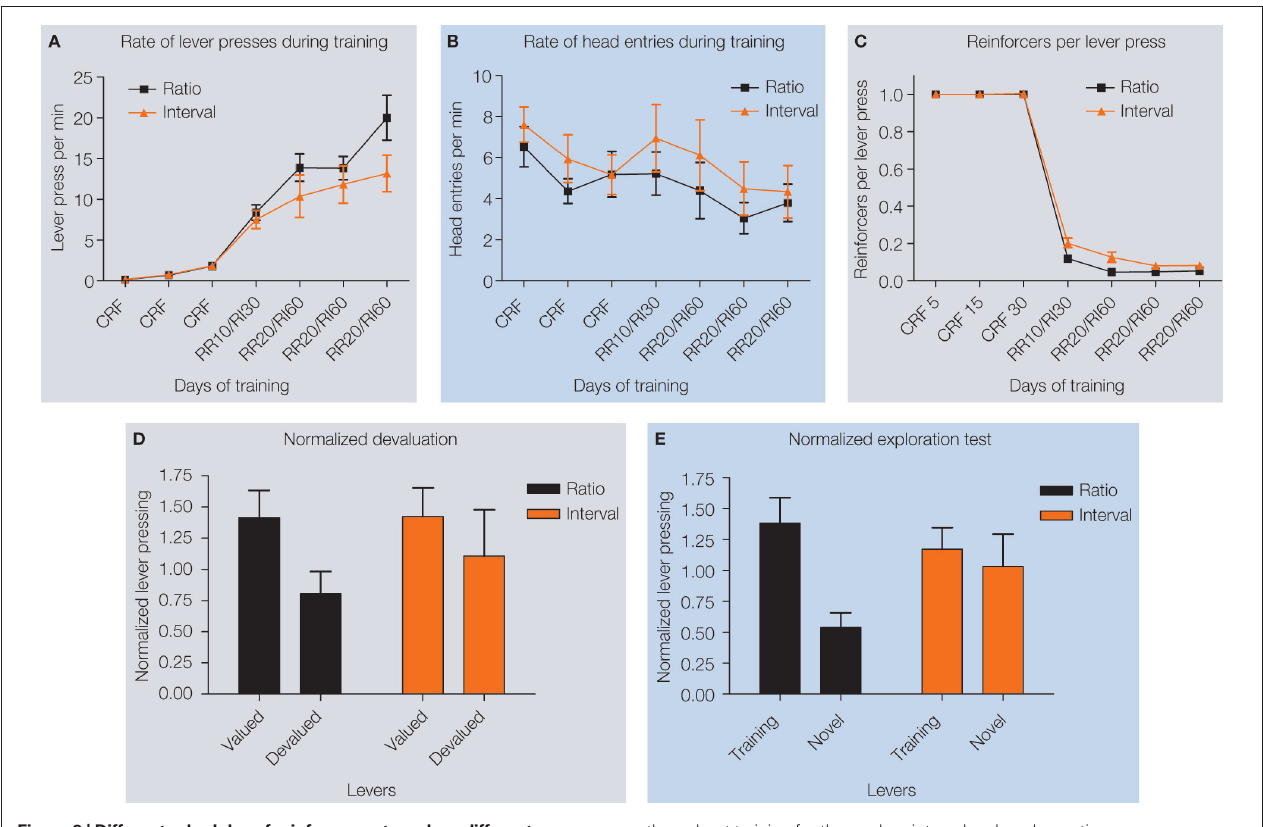
Figure 2 | Different schedules of reinforcement produce different predisposition to habit formation in C57Bl6/J mice. (A) Acquisition of the lever pressing task in animals trained on random ratio and random interval schedules. The rate of lever pressing (per minute) for each daily session is depicted. (B) Average rate of head entry throughout training for the random interval and random ratio groups. (C) Rate of reinforcement per lever press